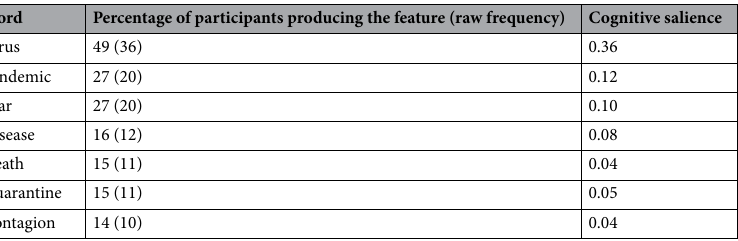
Table 1. Words produced for ‘COVID-19’ by at least 10% of participants ordered according to their frequency, and their cognitive salience index.